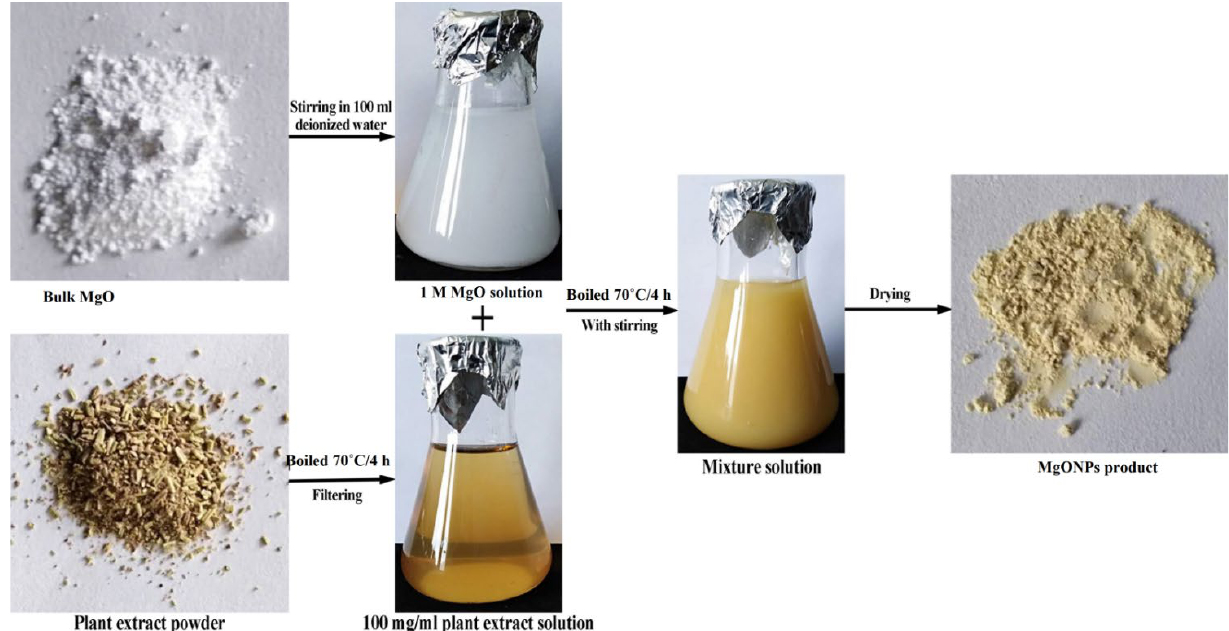
Figure 4. Flowchart diagram of the green synthesis of MgO-NPs using rosemary flower extract (source: [33]).